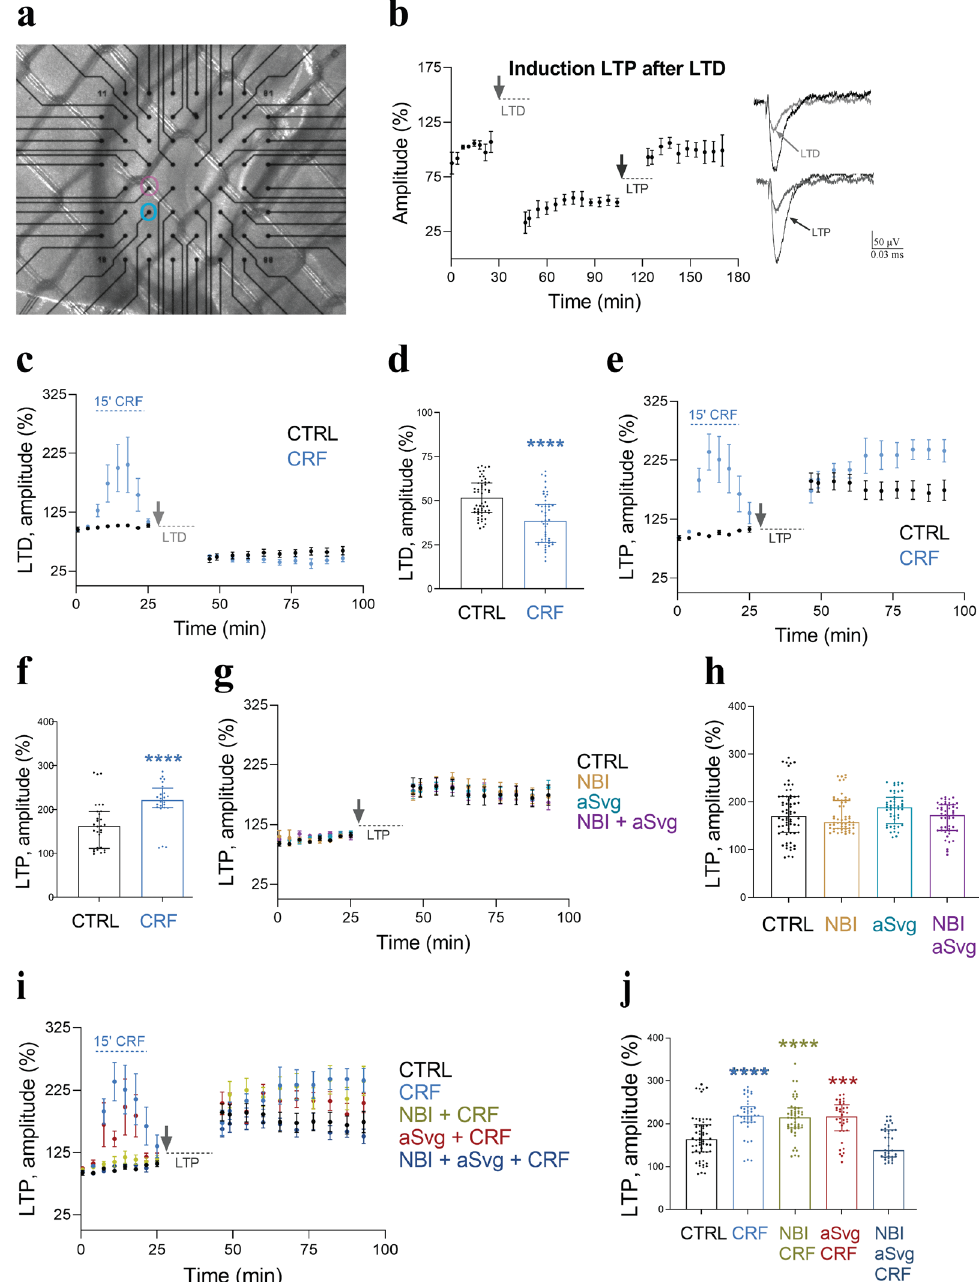
Fig. 4 CRF can augment long-term synaptic plasticity via CRF-R1 or CRF-R2 activation. Multi electrode array recording of evoked fEPSP from the SC in the CA1. a Image of a mouse acute hippocampal slice on the multi electrode array (MEA2100; Multi channel Systems) used for fi eld excitatory postsynaptic potential (fEPSP) recordings with the stimulation electrode (blue) and recording electrode (pink) to stimulate Shaffer collateral-CA1 connections. b Consecutive long-term depression (LTD) and long-term potentiation (LTP) induction. Baseline fEPSPs were recorded for approximately 25 min, LTP induction protocol was applied to the same slices and recording continued for another 60 min. c LTD in control slices (black) and slices treated with CRF (15 min, 100 nM CRF). Treatment period indicated with dashed line (blue). d Averaged fEPSC amplitude 60 min after LTD induction (normalized to baseline), (shown as median with IQR. CTRL: N = 9 animals; CRF: N = 8; Mann – Whitney test (U = 631). **** p < 0.0001). CRF treatment increased LTD by 17% compared to control. e LTP in control slices (black) and slices treated with 100 nM CRF (blue) for 15 min. Treatment period indicated with dashed line. f CRF increased LTP ef fi ciency by 32% (shown as median with IQR. CTRL: N = 11 animals; CRF: N = 9; Mann – Whitney test (U = 139). **** p < 0.0001). g LTP induction in combination with either CRF-R1 blocker (NBI 1.2 µM), CRF-R2 blocker (aSvg 150 nM) or both. h CRF-R blockers do not affect LTP (shown as median with IQR. CTRL: N = 11; NBI: N = 9; aSVG: N = 8; NBI + aSVG: N = 8; Kruskal – Wallis test with Dunn ’ s multiple comparisons test (Kruskal – Wallis statistic = 6.357). P > 0.9999, p = 0.6285, p > 0.9999). i LTP induction in the presence of CRF-Rs blockers. Blockers were present throughout the recording. j Effect of CRF on LTP can be established via both CRF-Rs pathway, but no additivity was found if both pathways are available (shown as median with IQR. CTRL: N = 11; CRF: N = 9; NBI: N = 9; NBI + CRF: N = 9; aSVG: N = 8; aSVG + CRF: N = 8; NBI + aSVG: N = 8; NBI + aSVG + CRF: N = 8; Kruskal – Wallis test with Dunn ’ s multiple comparisons test (Kruskal – Wallis statistic = 94.32). *** p < 0.0005, **** p <